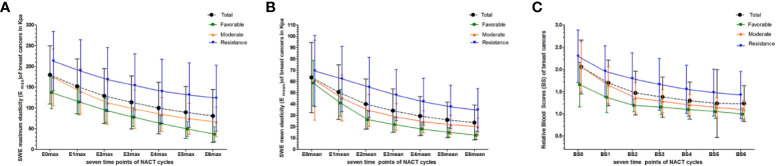
Dynamic changes in Emax, Emean, and BS were measured at seven time points (baseline: t0; interim: t1–t5; and before surgery: t6) for total and different pathological response groups. (A) Emax at t0–t6; (B) Emean at t0–t6; (C) BS at t0–t6.